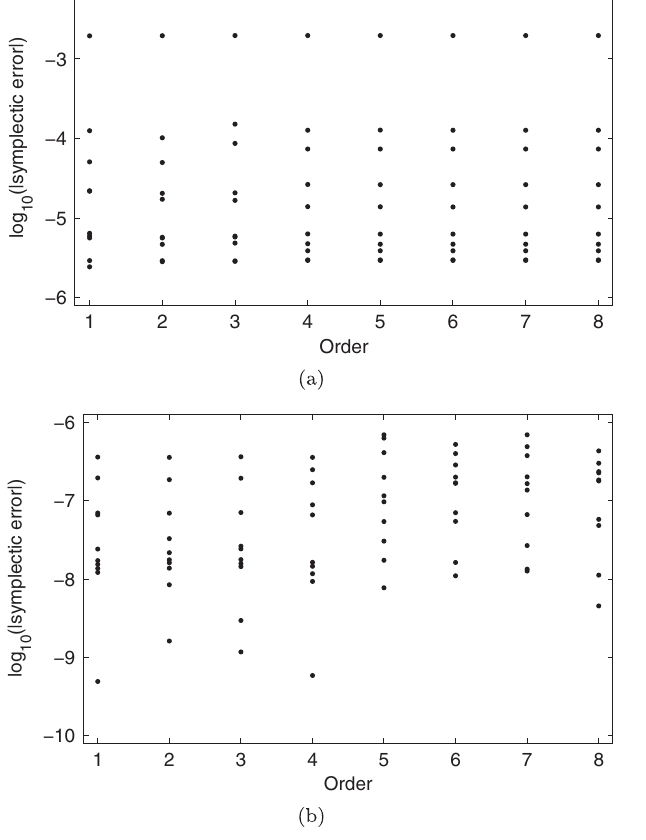
FIG. 12. Terms in the matrix E characterizing the symplectic error, with increasing order of the terms, for particular values of the dynamical variables. (a) Map obtained by interpolation of the coefficients of Taylor maps, with dynamical variables given the value 0.001. (b) Map obtained by interpolation of MVGFs, with dynamical variables given the value